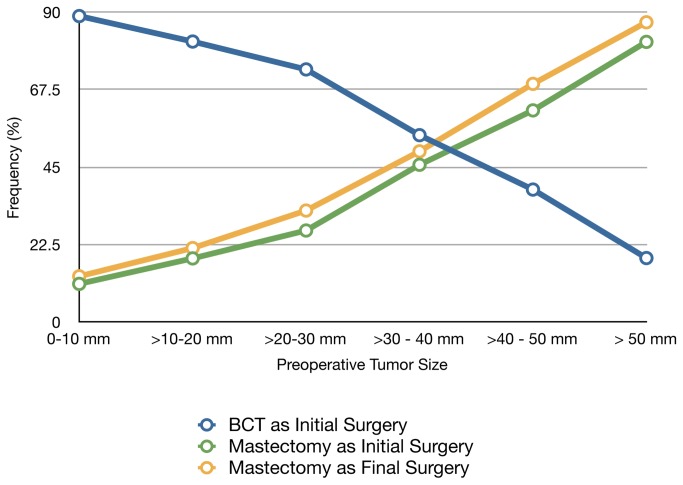
Frequency of Surgery Modalities according to Tumor SizeAs tumor size increases, the frequency of breast conservation therapy (BCT) decreases and the frequency of mastectomy as initial or final surgery increases. At a tumor size of >30 - 40 mm, an approximate 1:1 ratio exists between BCT and mastectomy.